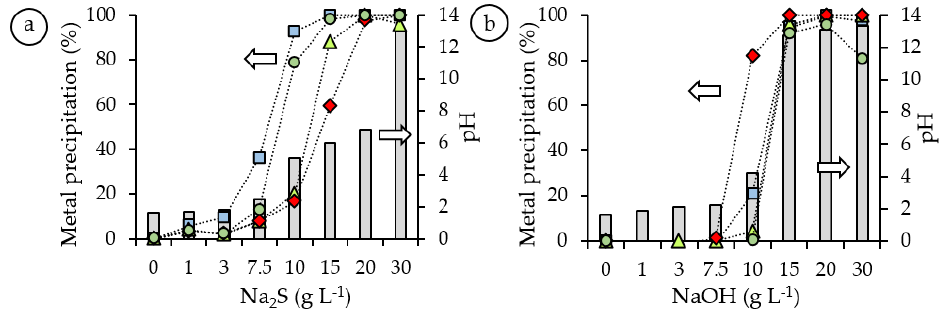
Figure 9. Effect of ( a ) Na 2 S and ( b ) NaOH dosage on metal precipitation yield (circles (Cu (blue square), Fe (red diamond), Ni (yellow triangle) and Zn (green circle))) and pH evolution (columns).